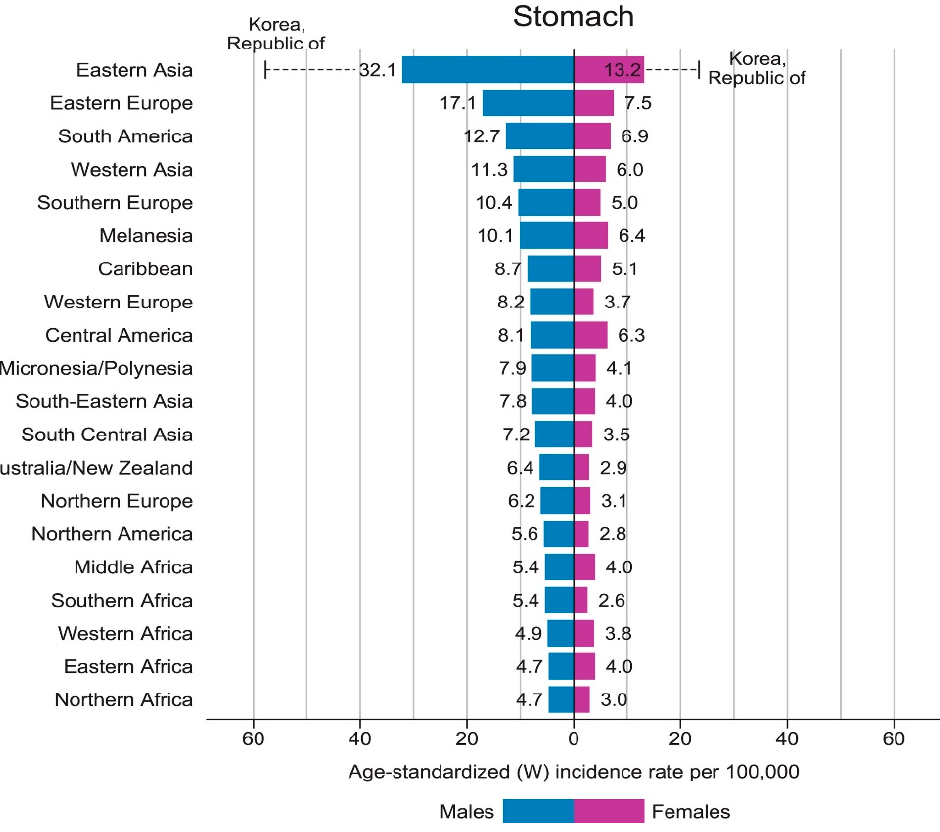
Figure 2. Age-standardized region-specific incidence (GLOBOCAN data) for gastric cancer in 2018. Adapted from Bray et al. (2018) with permission [1].